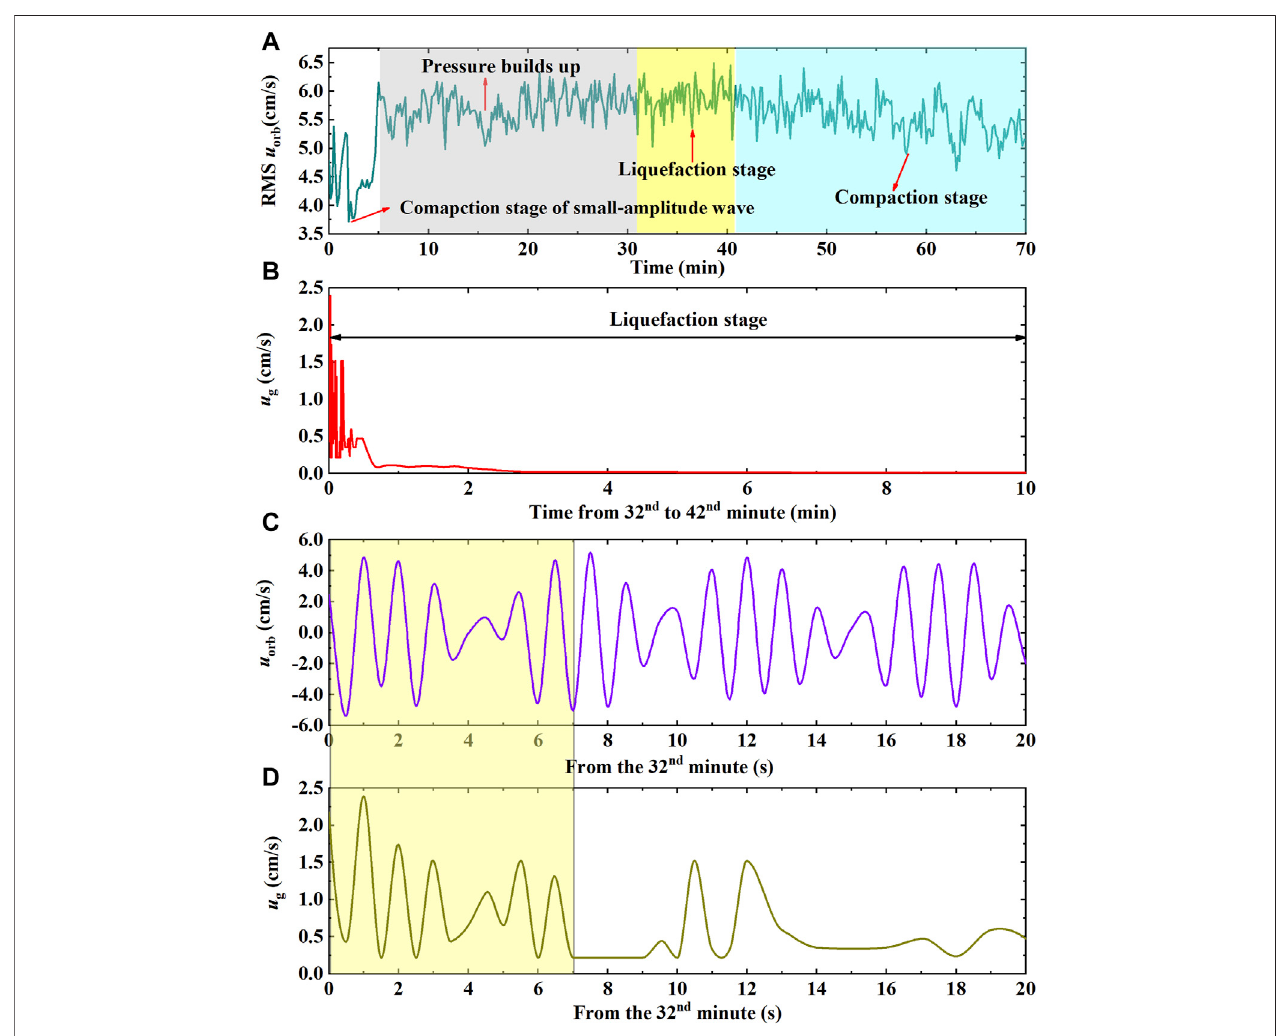
FIGURE 5 | Time series records of wave orbital velocity and the WILSGF velocity. (A) RMS wave orbital velocity (RMS u orb ) of the experiment. The white region indicatesthesmall-amplitude-wavecompactionstage,thegrayregionindicatesrepresentstheporewaterpressureestablishmentstage,theyellowregionindicatesthe liquefaction stage, and the light blue scale represents the compaction stage. (B) Plot of the velocity of the WILSGF ( u g ) , from the 32nd min to the 42nd min. (C) Instantaneous wave orbital velocity in the 20 s, period from the 32nd min. (D) WILSGF velocity u g in the 20 s, period from the 32nd min.